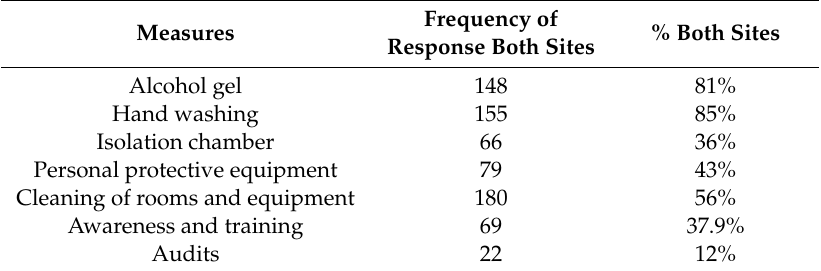
Table 6. Strategies reported for both sites regarding infection control.